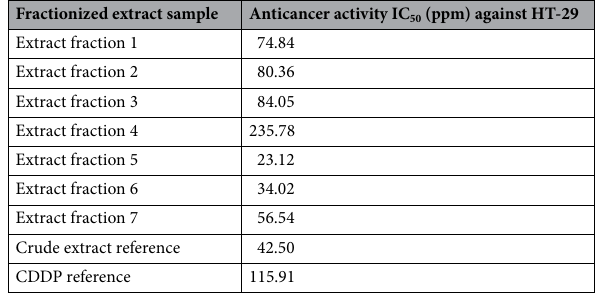
Table 6. Anticancer IC 50 of fractionized extract against colorectal cancer cell